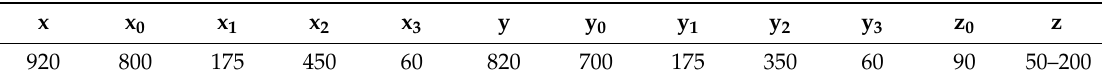
Table 2. IPT dimensions (all dimensions are in mm).